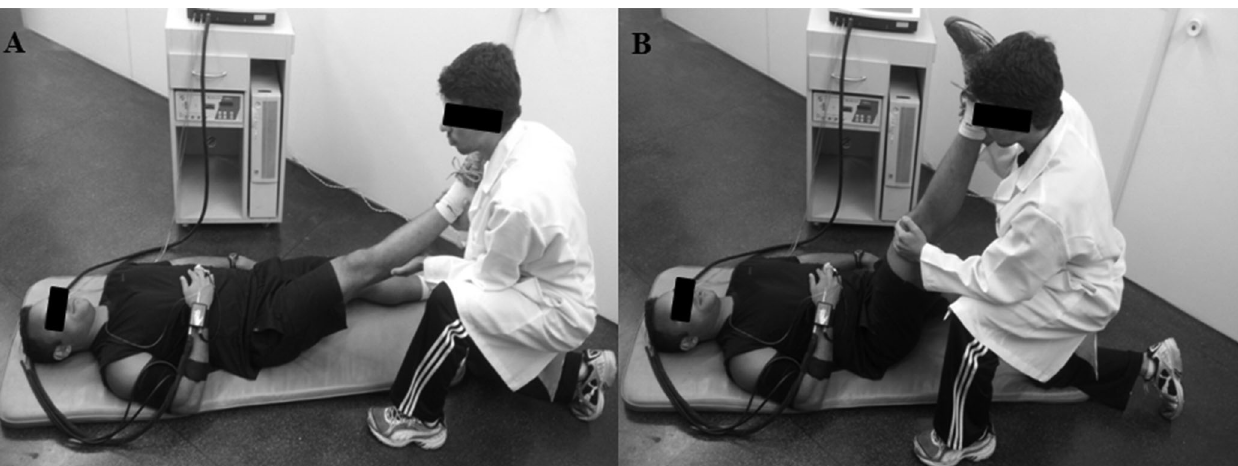
Figure 1 - Unilateral hip flexion stretching exercise: (A) before moving the segment to the maximum range of motion; and (B) at the maximum range of motion. Evaluators responsible for stabilizing the hip joint and measuring the duration of stretching and intervals between sets are not shown for the sake of clarity.